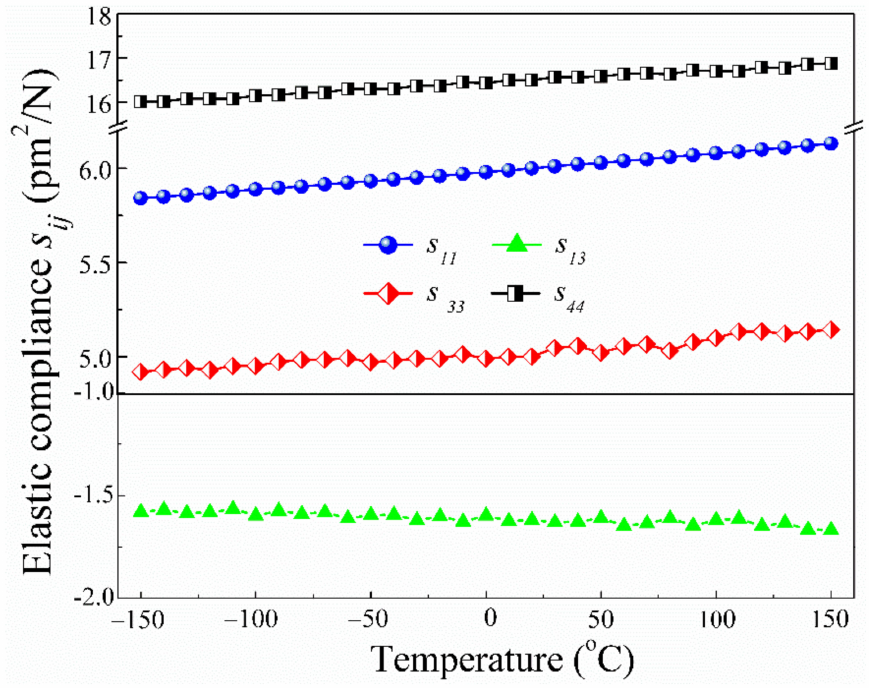
Figure 3. Variation of elastic compliance s ij for LN